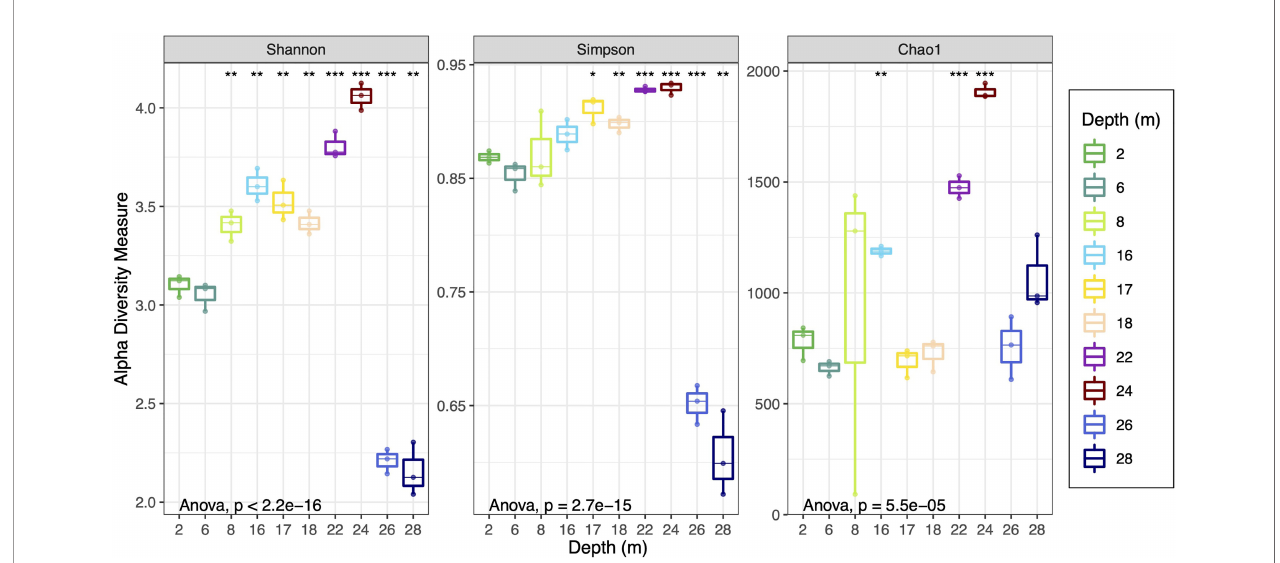
FIGURE 3 | Shannon, Simpson and Chao1 alpha diversity metrics for all depths as box-and-whisker plots. Replicates are represented by dots on the box plots. Each box represents interquartile range; the line inside the box is the median. The results of an ANOVA to indicate the level of support for intergroup difference overall are shown in the bottom of each panel. Pairwise comparisons using Student ’ s t-test were also conducted and asterisks at the top of each panel represent signi fi cance of the difference between the 2 m samples and the sample the asterisk is above, where “ * ” , “ ** ” and “ *** ” , respectively represent p-values than less or equal to 0.05, 0.01 and 0.001 and no asterisk indicates p-values were above 0.05. Supplementary Tables 4B – D contain all the pairwise test p-values.